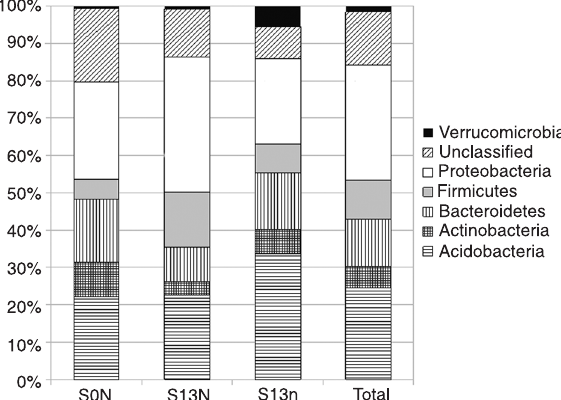
Figure 1. Distribution of the predominant phyla identified in the soil samples on the basis of 16S rRNA gene libraries from sug- arcane rhizosphere soil. Classification was achieved using the Ribosomal Database Project Classifier (http://rdp.cme.msu.edu/) with a threshold level of 50%. The bar labeled “total” shows the phylum distribution for the three samples combined. Distribution of minor phyla is not shown. Samples were collected from soils under sugarcane crop, observing the following conditions: S0N = soil from 12-month-old plant roots, N-fertilized; S13n = soil from 13-month-old plant roots, no N fertilization; S13N = soil from 13- month-old plant roots, N-fertilized.